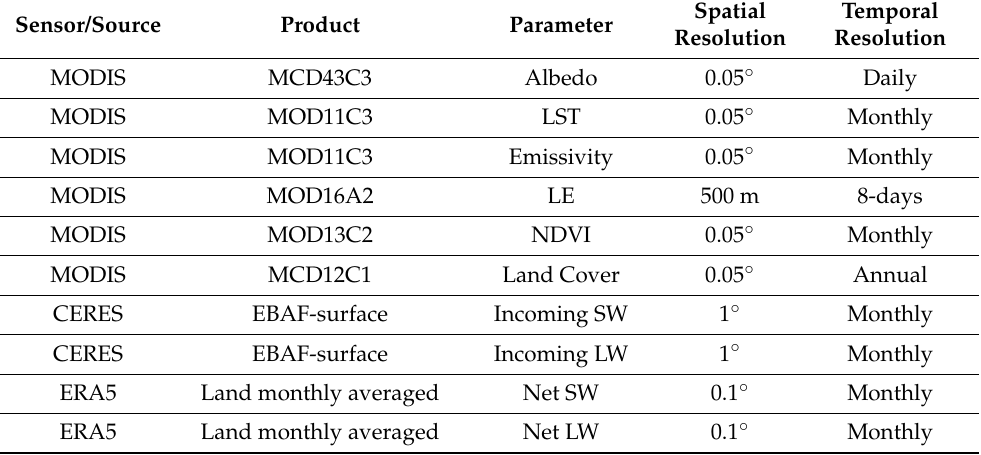
Table 2. Summary of the satellite, reanalysis data and ground observations used in this